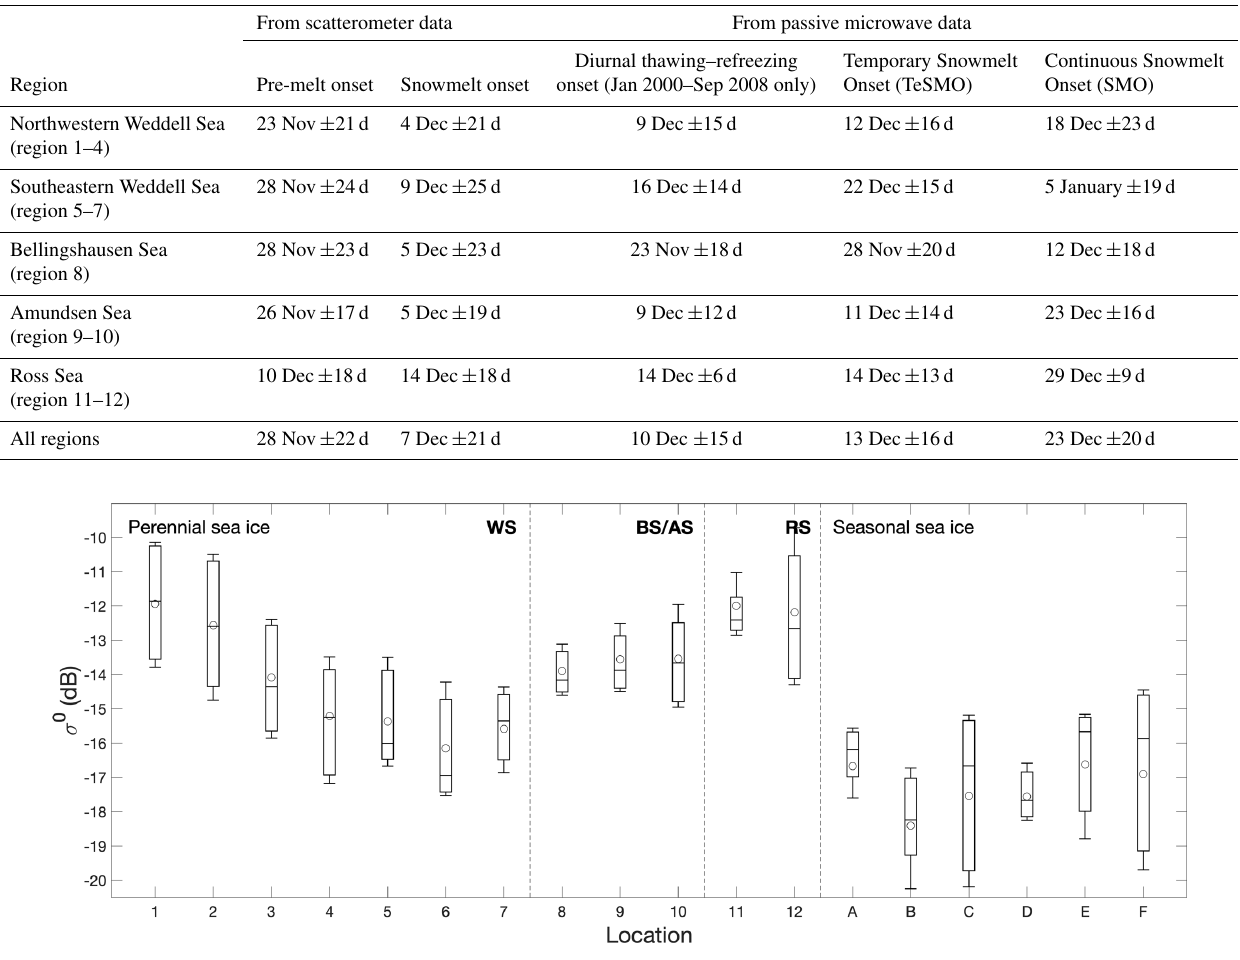
Figure 5. Summary of mean radar backscatter σ 0 (Ku and C band) and range of seasonal variability for all study locations during the complete 23-year study period (see Figs. 2 and 3). Boxes are the first and third quartiles. Whiskers display the 20th and 80th percentiles. Circles indicate mean, horizontal lines median values. Abbreviations are according to Fig. 1: WS – Weddell Sea, BS/AS – Bellingshausen and Amundsen seas, RS – Ross